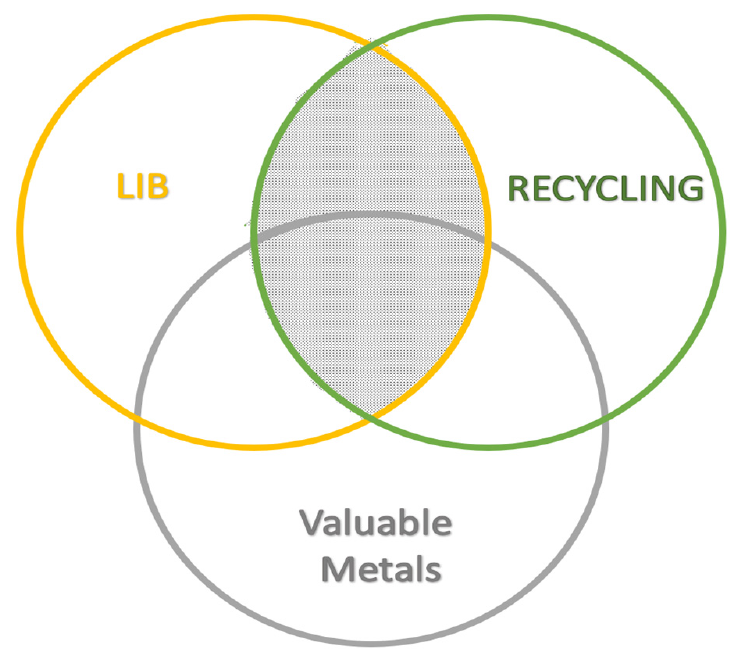
Figure 1. Research